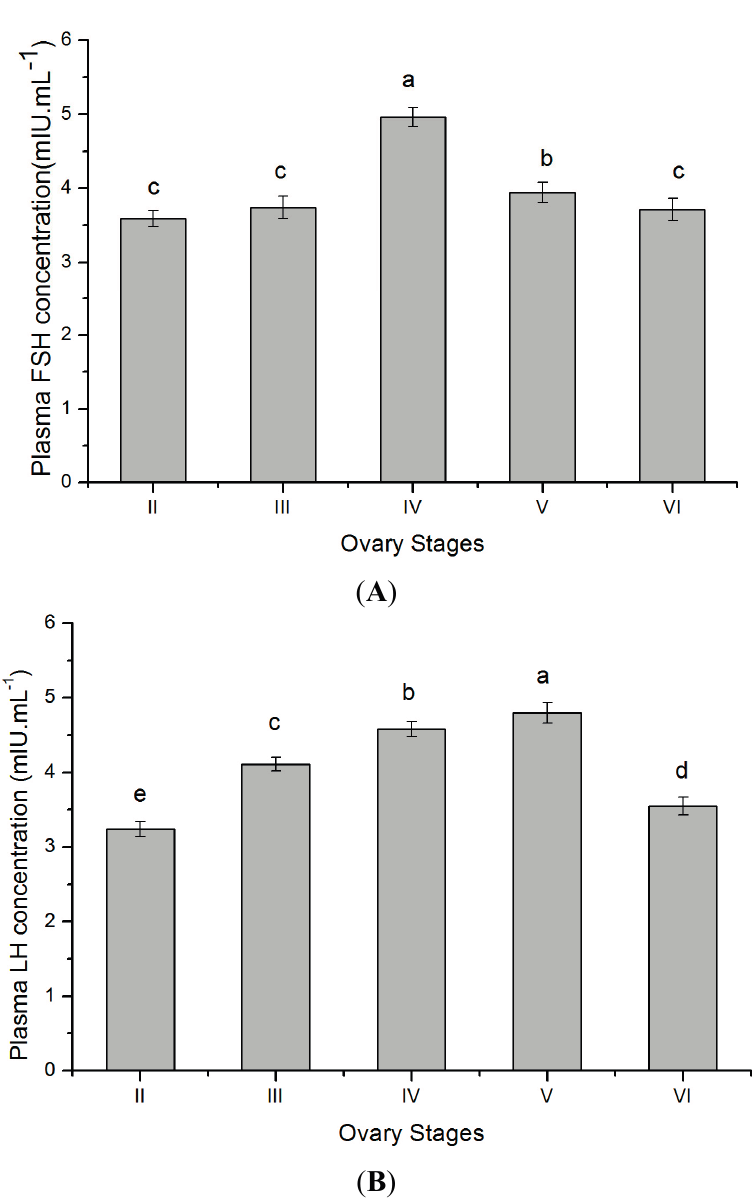
Figure 8. Concentration of plasma FSH ( A ) and LH ( B ) at different ovary stages in maturing C. semilaevis ( n = 4) . Each bar represents the mean ± SE. The different letters differ significantly from each other ( p <